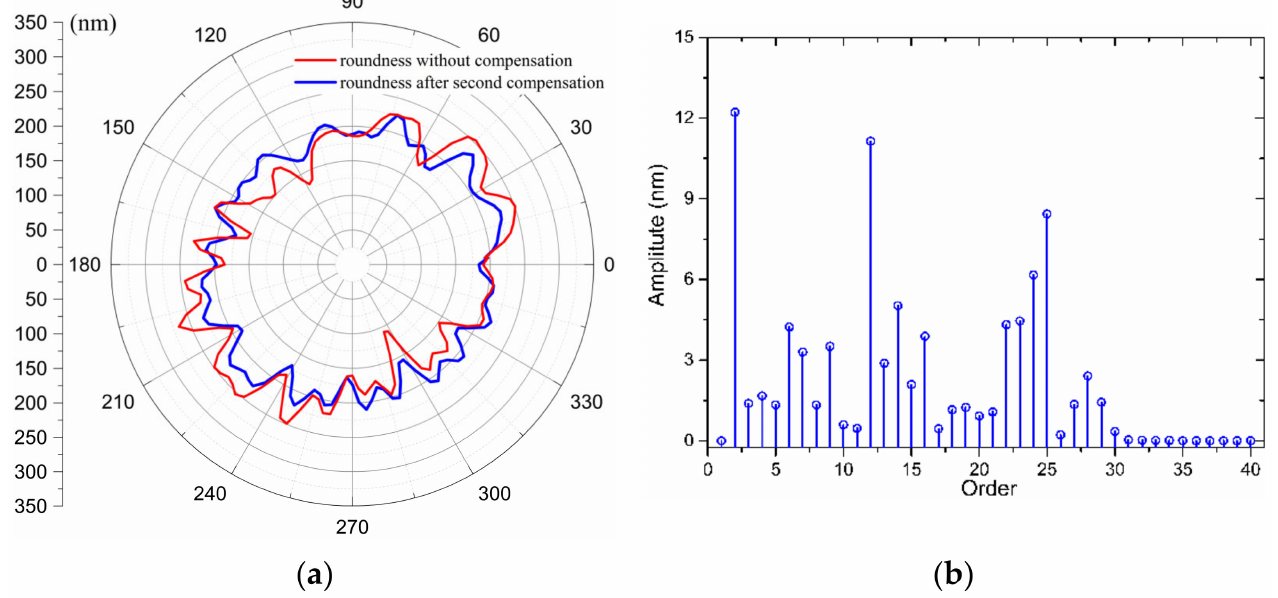
Figure 17. WRE of the mandrel and its spectrum after second compensation: ( a ) WRE graph in a polar coordinate system, ( b ) Error